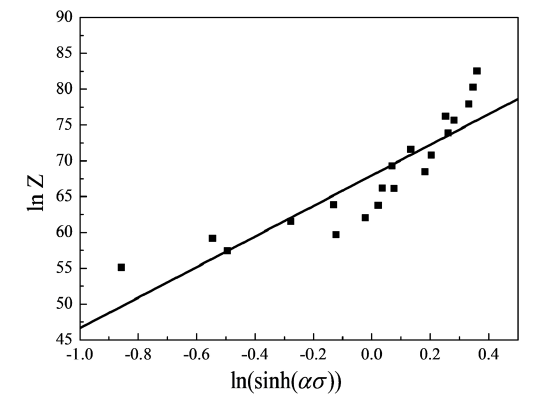
Figure 9. Variation of the Z parameter with flow stress (at strain of